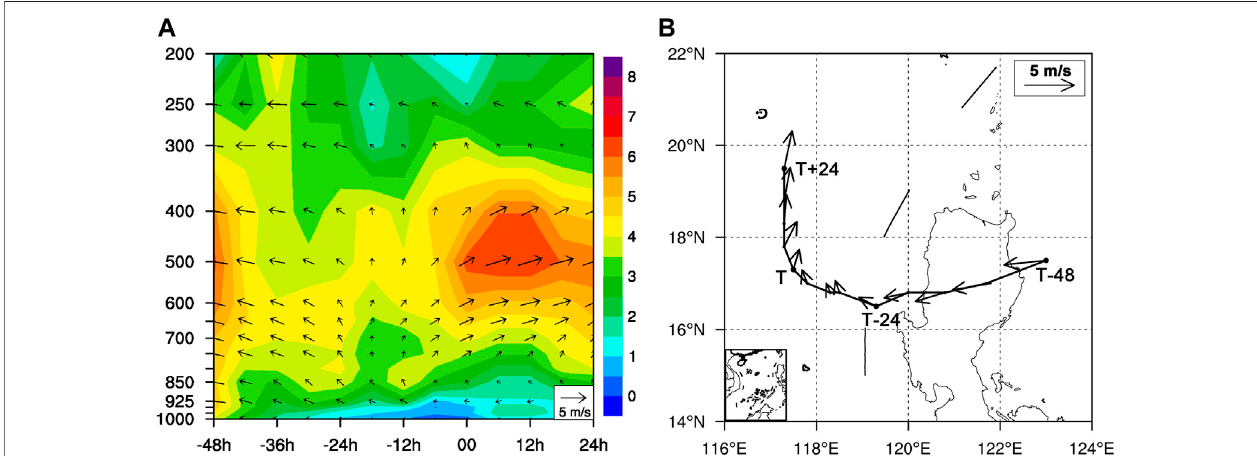
FIGURE 3 | (A) The time series of the vertical distribution of the mass-weighted mean steering fl ow (averaged in a region of a radius of 400 km from the TC center) (Vectors are wind speed and direction, shaded means magnitude of wind speed, Unit: m s − 1 .) and (B) the averaged steering fl ow vectors between 850 hPa and 300 hPa.